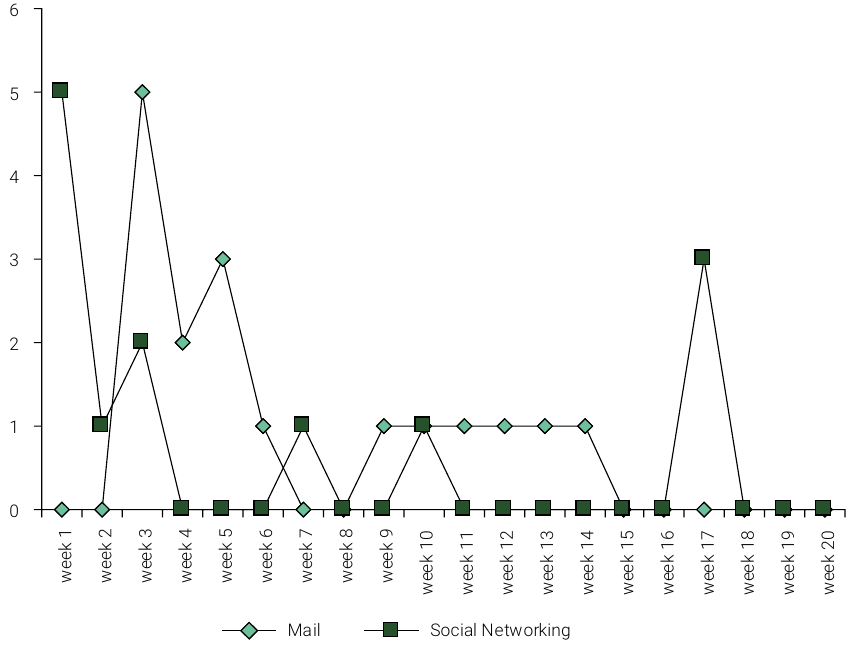
Figure 1. Return rate of questionnaires during the initial 30 days (A) and after 150 days of the start of the research